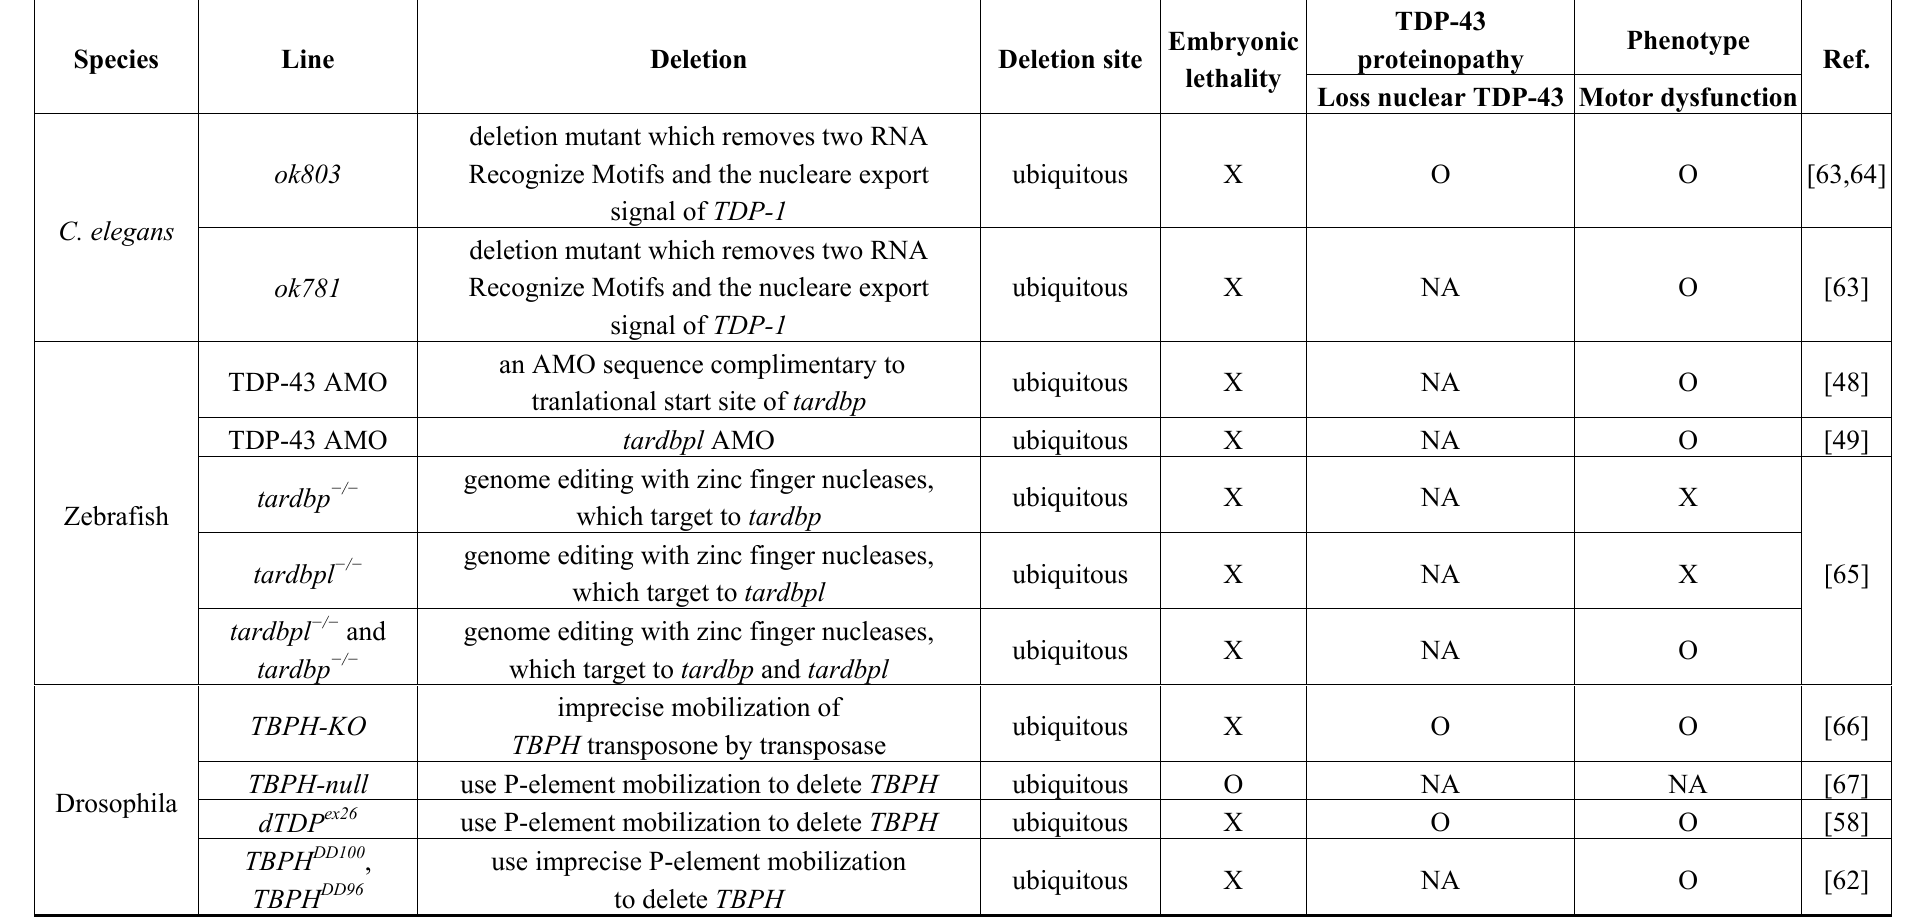
Table 5. Non-mammalian model: TDP-43 knockout model (NA: